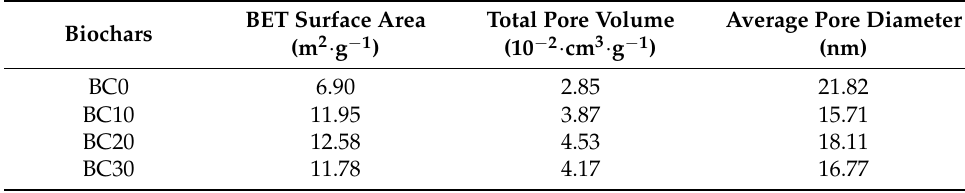
Table 2. Microstructure properties of biochars derived from HS-PP blends.